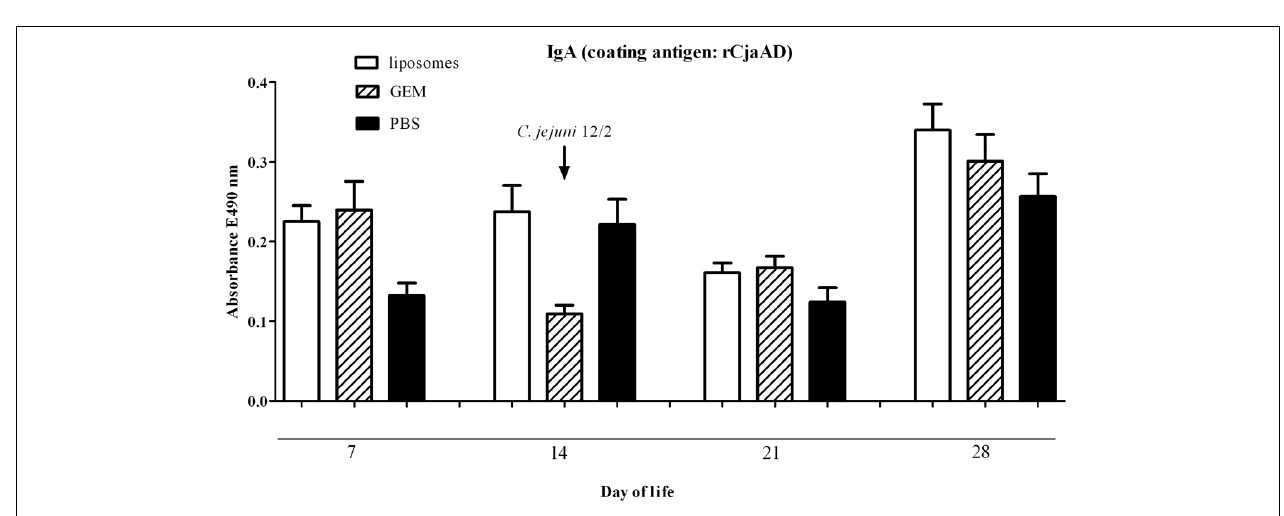
FIGURE 3 | Immune responses of chickens vaccinated in ovo with GEM particles presenting rCjaAD-LysM on their surface or liposomes containing rCjaAD. Levels of mucosal sIgA antibodies specifically recognizing rCjaAD antigen were determined by ELISA. Eighteen-day-old embryonated chicken eggs were inoculated with 0.1 ml GEM particles or liposomes and challenged with C. jejuni /pUOA18 on day 14 of life. Control birds were given PBS (solid bars). Intestinal samples were collected at the specified days of chicken life. Purified rCjaAD protein was used as a coating antigen. Intestinal secretion samples were diluted 1:10. Absorbance values represent a mean of 5 or 6 birds ± SD per time interval. No significant differences ( p < 0.05) between analyzed groups and control groups were